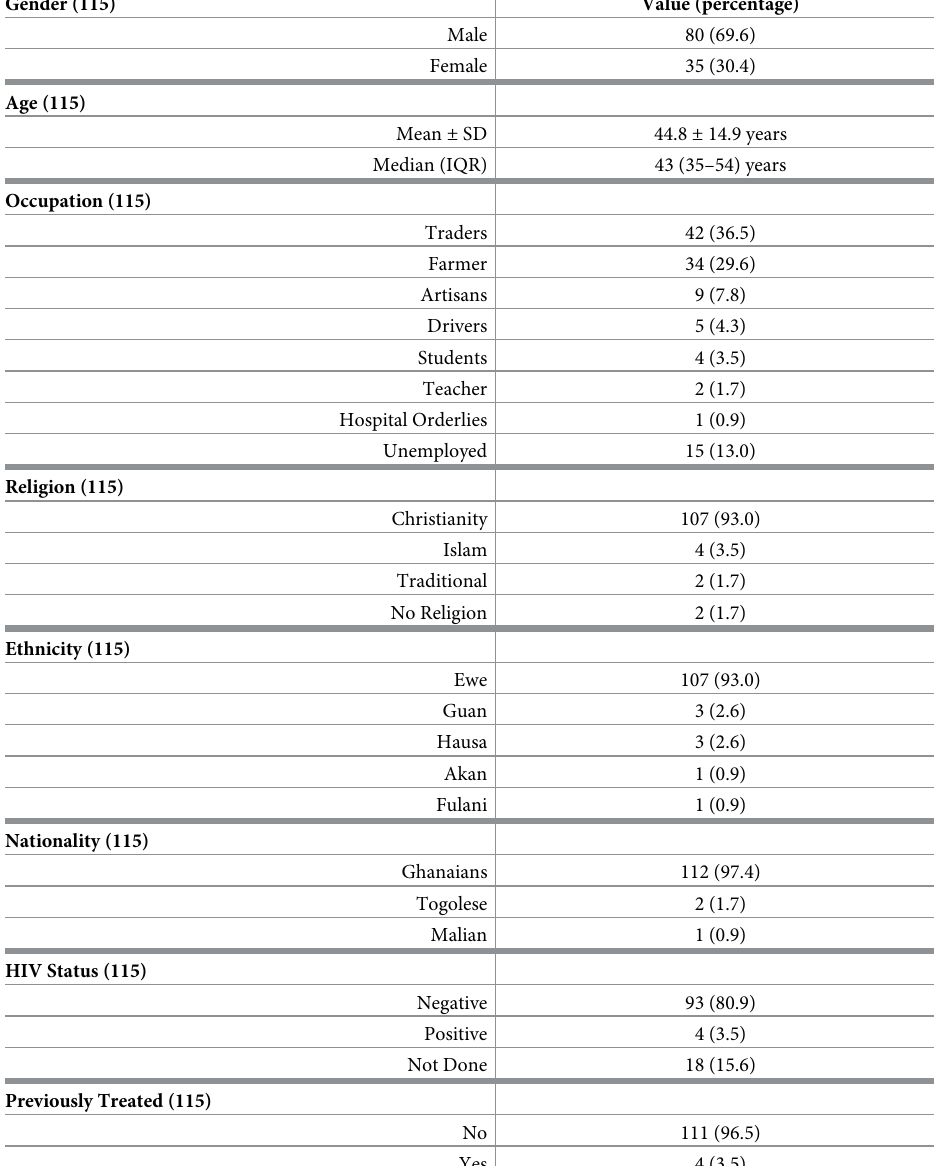
Table 1. Characteristics of MTBC positive